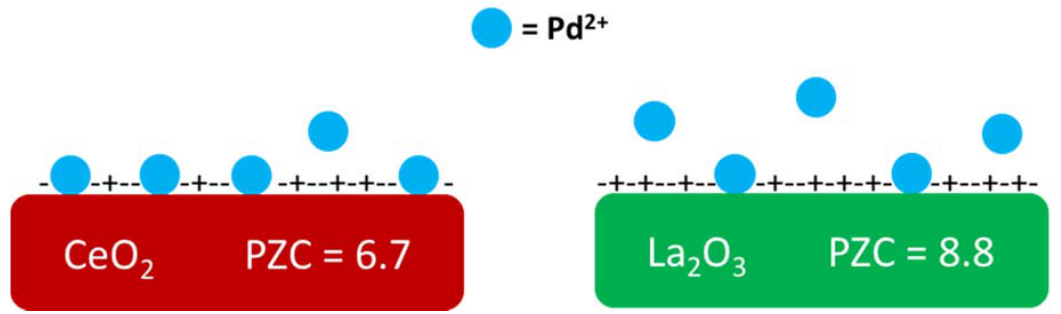
Figure 3. Representation of adhesion and release of Pd 2+ from CeO 2 and La 2 O 3 surfaces under catalytic conditions (pH ~ 10.5) [40] (Adapted with permission from The Royal Society of Chemistry).